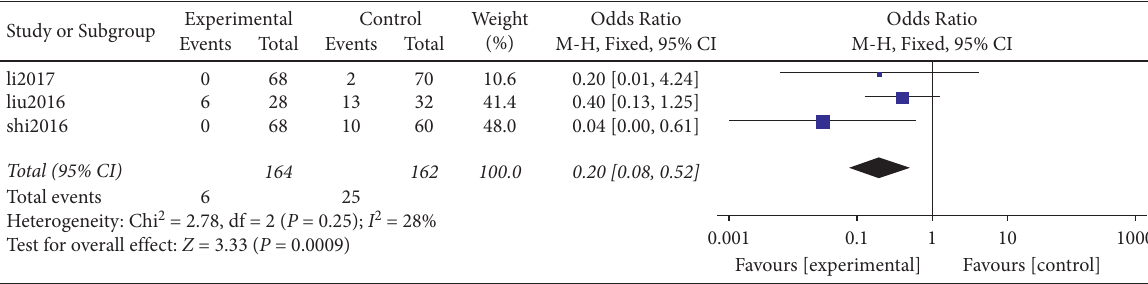
Figure 12: Screw loosening after